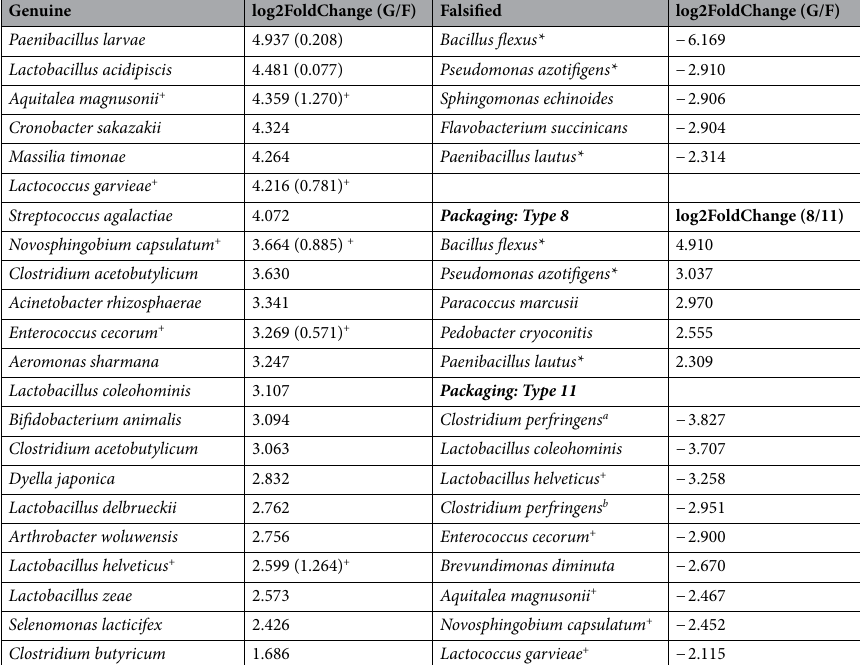
Table 2. Bacterial species identified as indicator taxa (differentially abundant) for genuine and falsified tablets and for packaging Type 8 or 11. Positive log2FoldChange (G/F) values indicate ‘Genuine’ indicator taxa and negative log2FoldChange (G/F) values indicate ‘Falsified’ indicator taxa. Positive log2FoldChange (8/11) values indicate ‘Falsified Type 8’ indicator taxa and negative log2FoldChange (8/11) values indicate ‘Falsified Type 11’ indicator taxa. *indicates species identified as ‘Falsified’ indicator taxa and ‘Falsified Type 8’ indicator taxa. + indicates species identified as ‘Genuine’ indicator taxa and ‘Falsified Type 11’ indicator taxa. Two ASVs identified as Clostridium perfringens (subscript a and b) were differentially abundant in Type 11 samples.